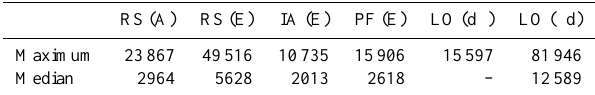
Table 11. Maximum and median travel distances L (m) com- puted for each process. RS–rock slides, IA–ice avalanches, PF– periglacial debris flows, LO–lake outburst floods, A–average, E– envelope, dfl–debris flow, fld–flood.